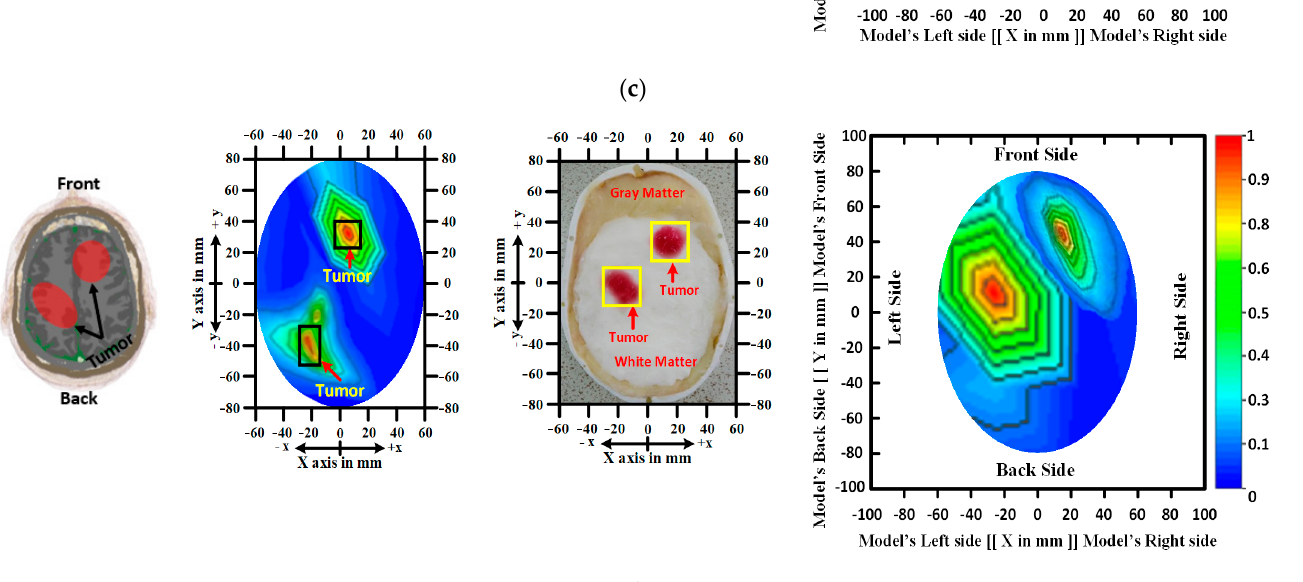
Figure 7. Comparision imaging results with simulated as considering real situations and formulated tissue − imitating phantom models with reconstructed images: ( a ) non-tumor, ( b , c ) single tumor, ( d ) double tumors.